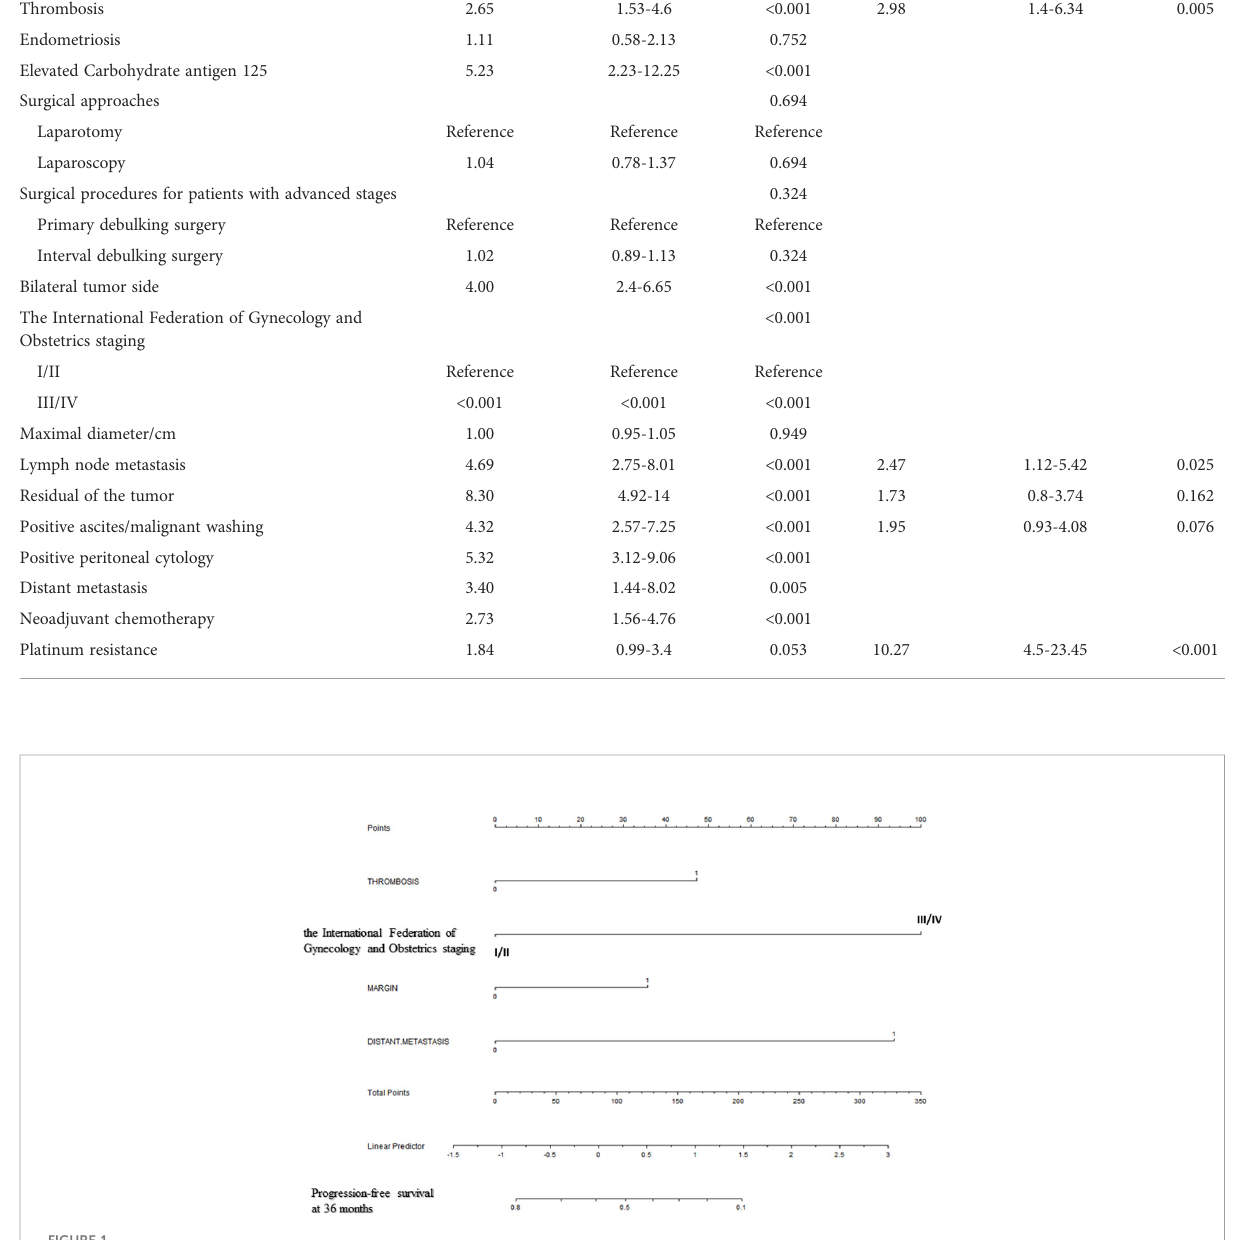
FIGURE 1 A Nomogram for Predicting Progression-free Survival of Patients With Resectable Ovarian Clear Cell Carcinoma After Primary Treatment. To calculate predicted progression-free survival, an individual patient ’ s value is located on each variable axis, and a straight line is drawn upward to the “ Points ” row to determine the points associated with each factor. After summing the total points, one locates the appropriate total point number and draws a straight line from this to the bottom rows to determine the patient ’ s predicted survival probability. (For each